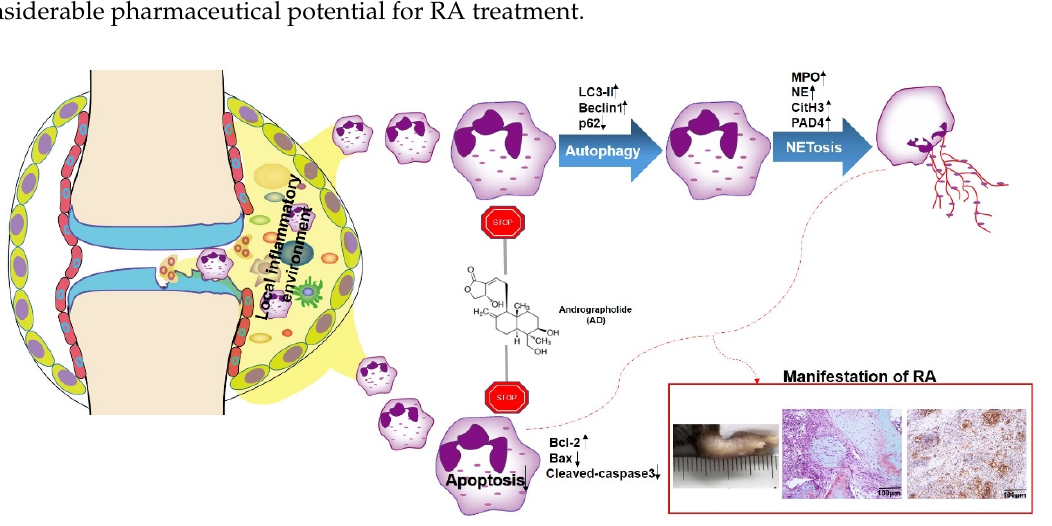
Figure 7. A graphical summary shows how andrographolide ameliorates rheumatoid arthritis by regulating the apoptosis–NETosis balance of neutrophils.